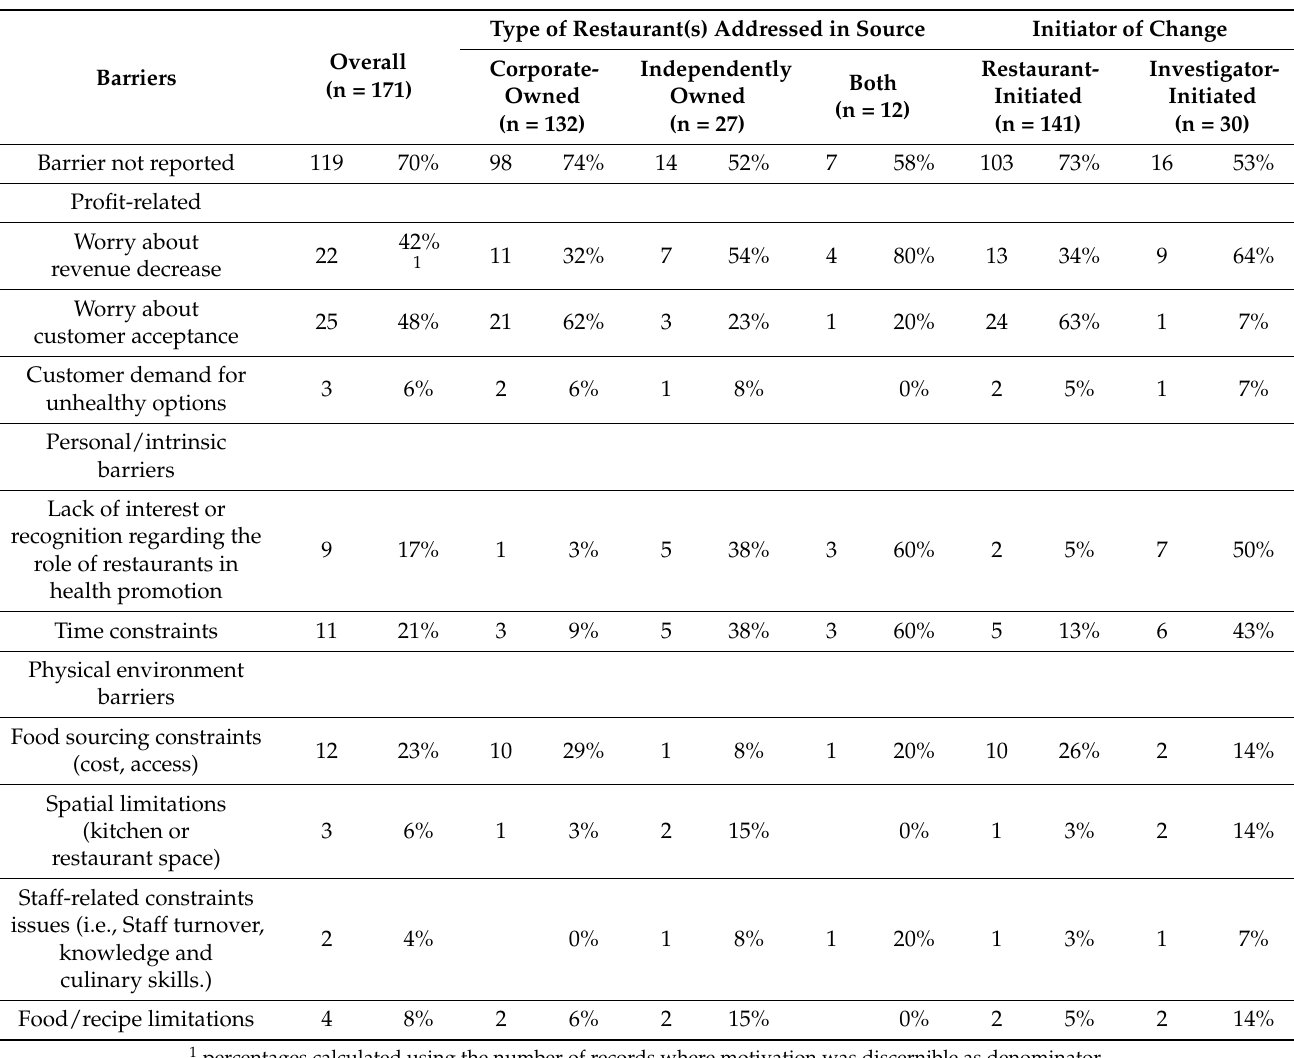
Table 3. Reported barriers for engaging in healthy eating promotion strategies, overall and stratified by restaurant type addressed and change